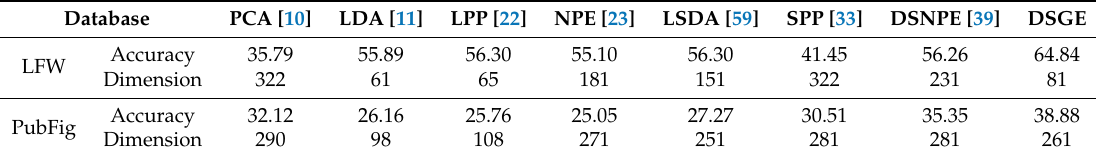
Table 6. The optimal recognition rates of each method and the corresponding dimension on the LFW and PubFig databases.